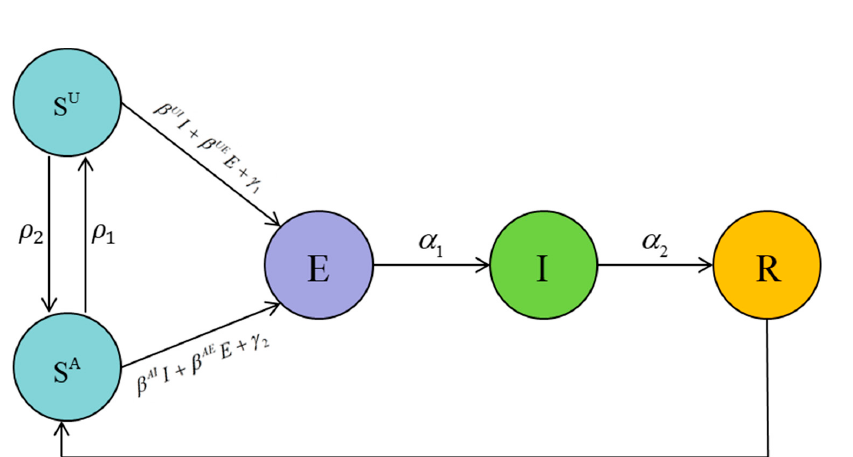
Figure 7. The schematic diagram of consciousness-based Susceptible-Exposed-Infective-Recovered (SEIR) model.